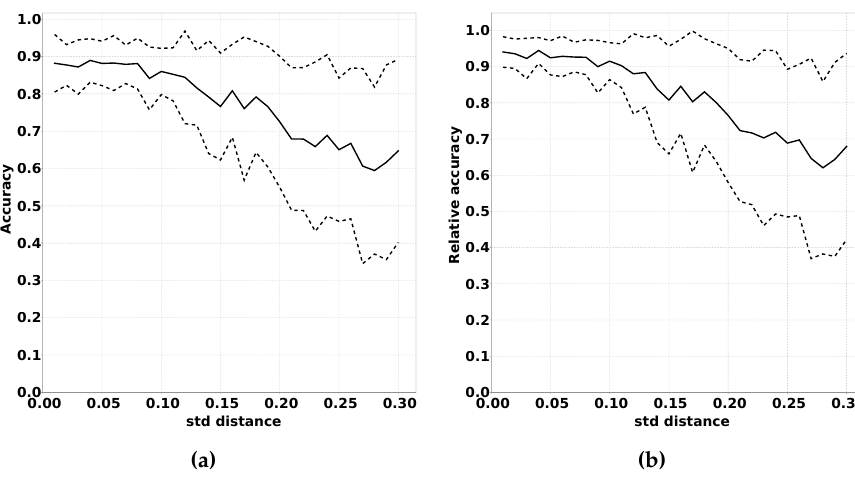
Figure 12. The effect of the variation of the frequency with which classes occur between the offline phase and the online phase. ( a ) Accuracy; ( b ) Relative